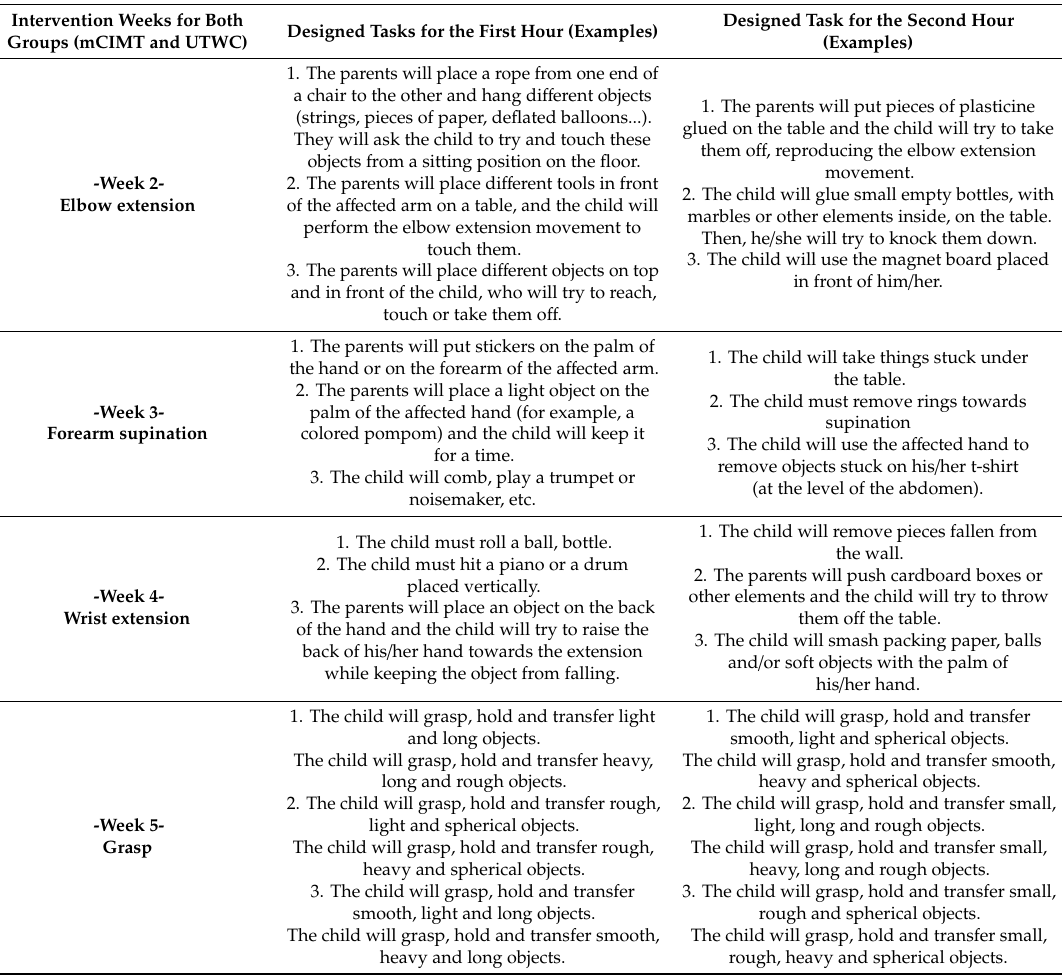
Designed Tasks for the First Hour (Examples)